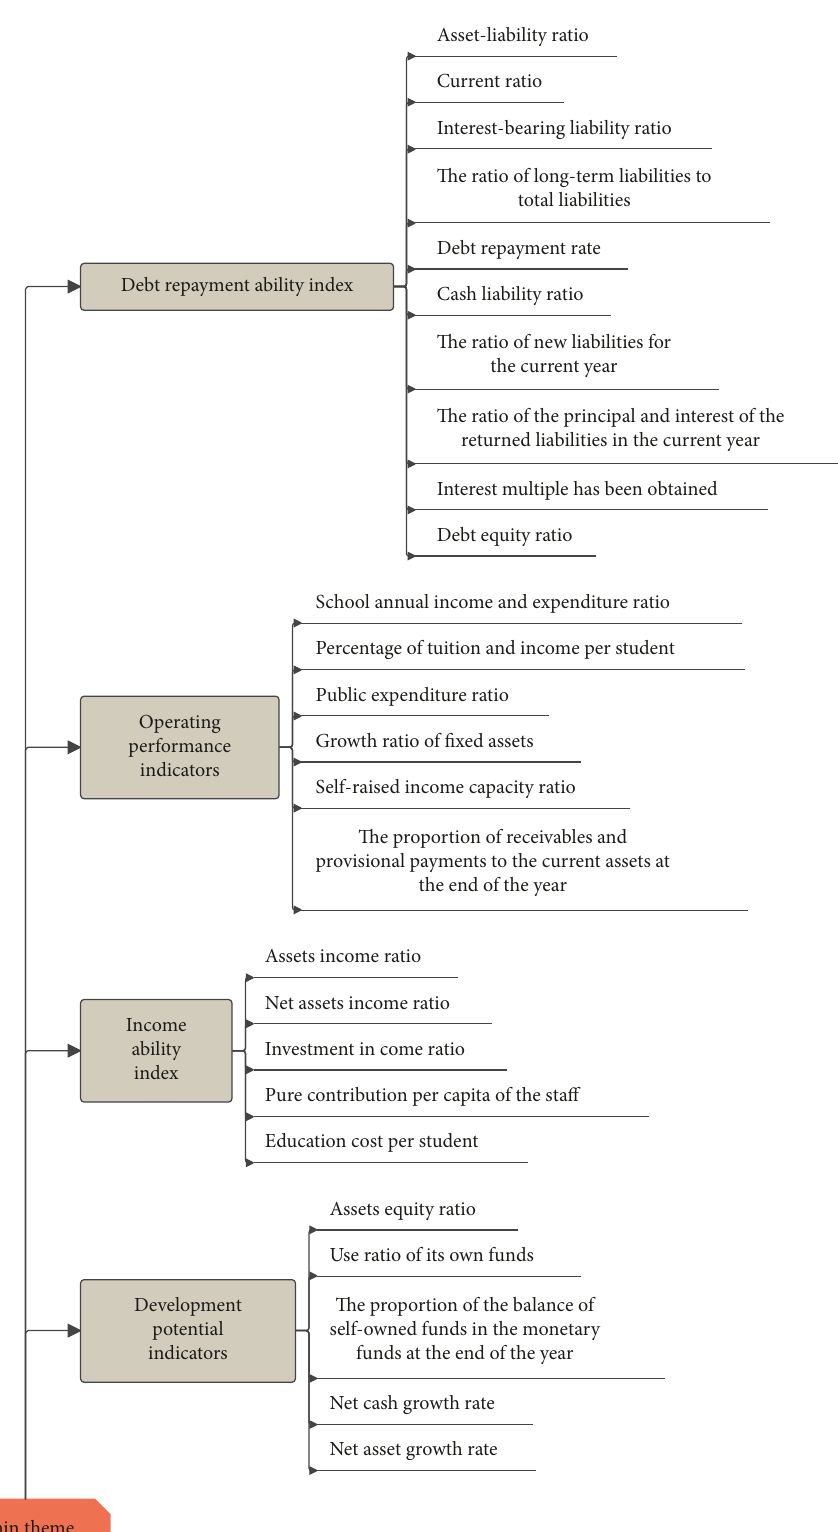
Figure 8: Comprehensive evaluation index system of financial risk in colleges and